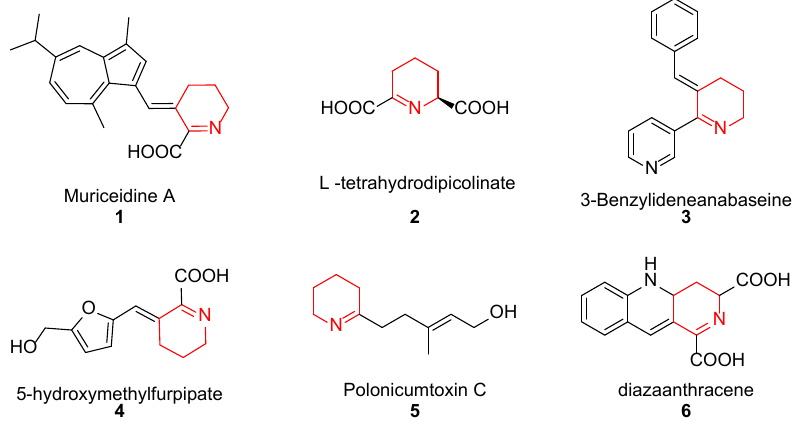
Figure 1. Chemical structure of some unsaturated piperidine derivatives.